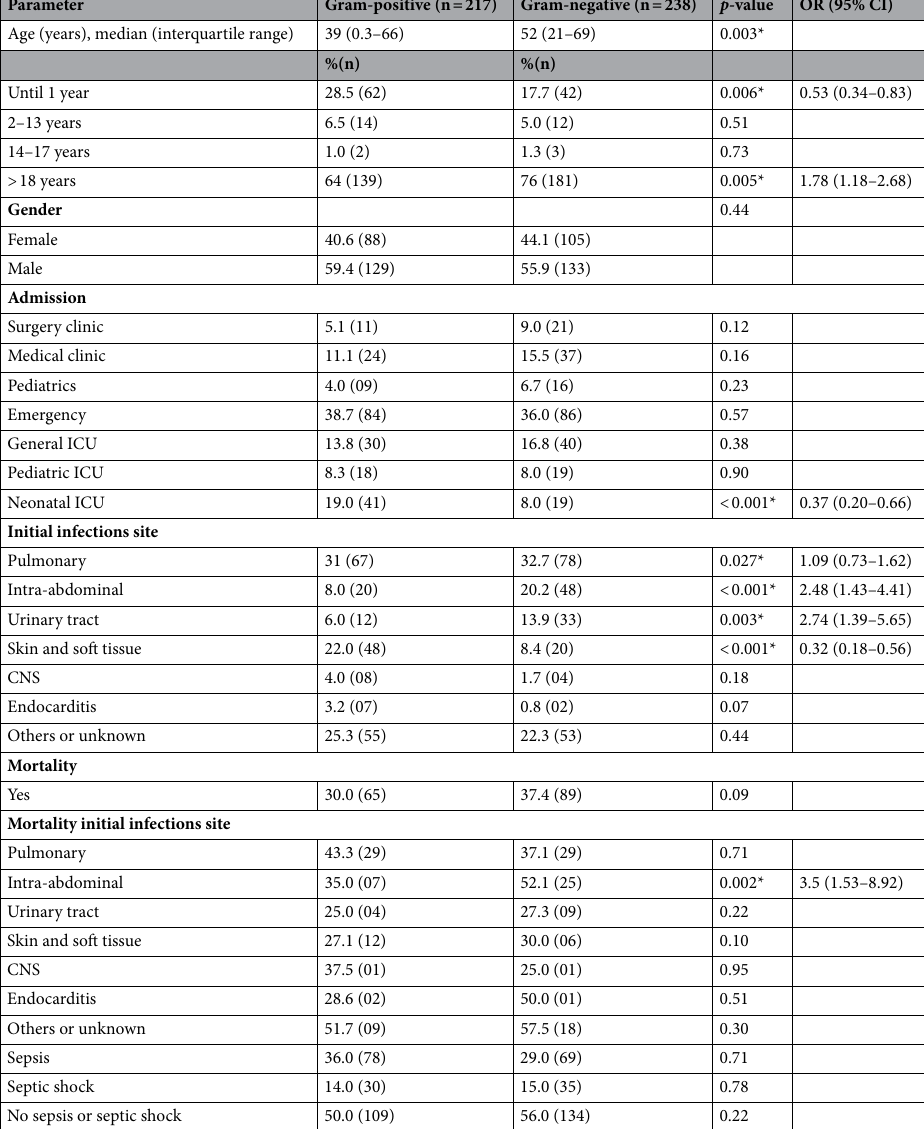
Table 1. General characteristics of all eligible patients. Data given the percentage and numbers of patients (n), Two-Sample t-Student test or Chi square Test, OR = Odds ratio (95% Confidence Interval). ICU = Intensive care unit, CNS = Central Nervous System. *Values of p < 0.05 were considered statistically